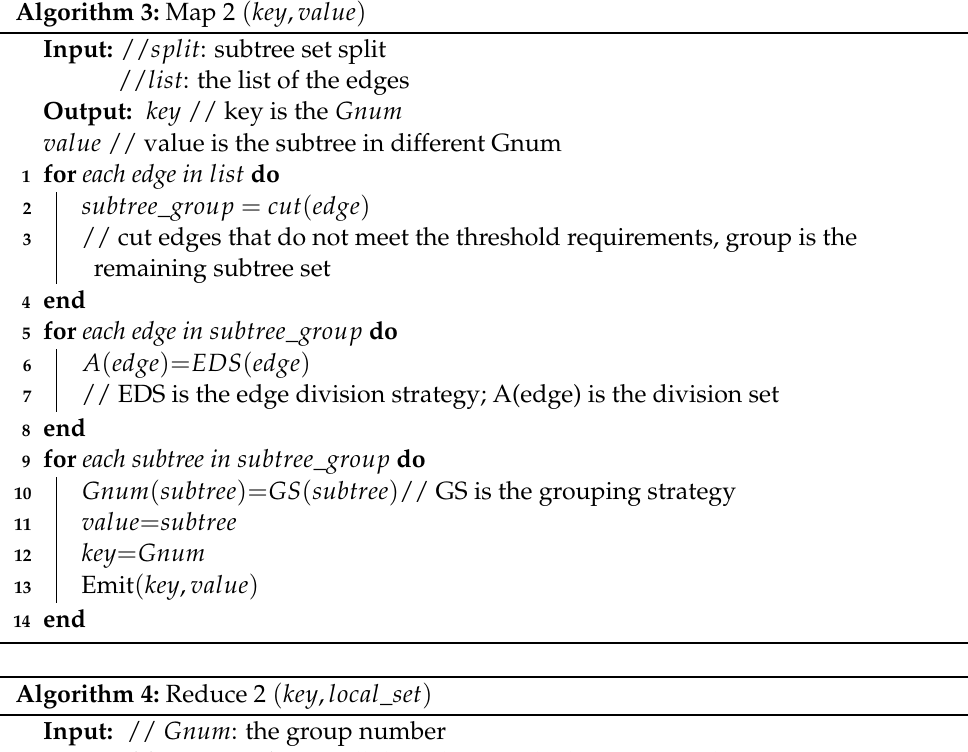
Algorithm 3: Map 2 ( key , value )